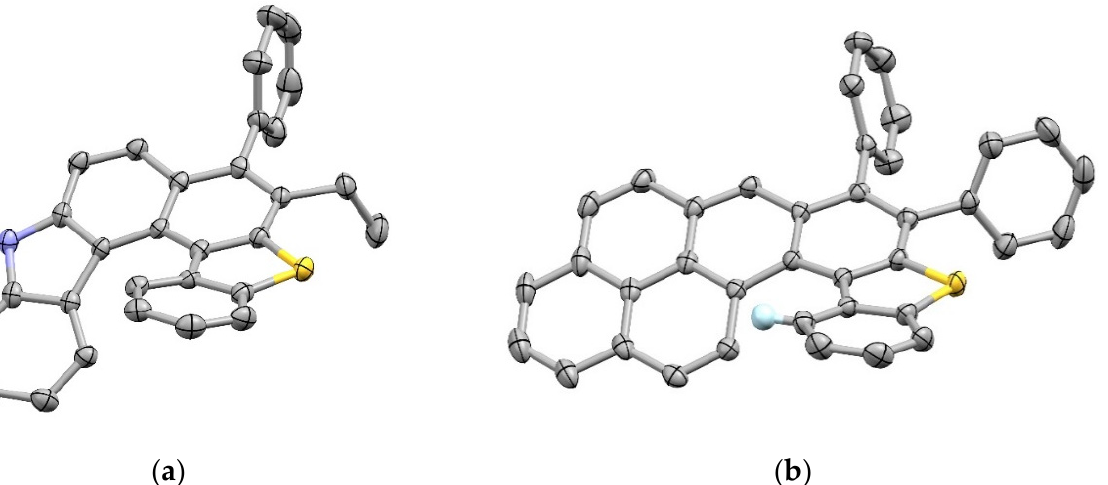
Figure 2. ORTEP style view of enantiomer M for compounds 1ac ( a ) and 3 ( b ). In compound 3 , hydrogen, represented in blue, corresponds to the doublet at 8.65 ppm in the 1 H NMR spectrum. Deposition number CCDC_2152004 (compound 1ac ); deposition number CCDC_2152005 (compound 3 ). The compound crystallizes in the chiral P2 1 2 1 2 1 space group and the molecule found was the enantiomer M . The naphthalene unit was slightly bent and the dihedral angle between the two benzene rings was 11.33(5) ◦ . Considering all fused rings, the most tilted ones were those involving the two heteroatomic units with the naphthalene group